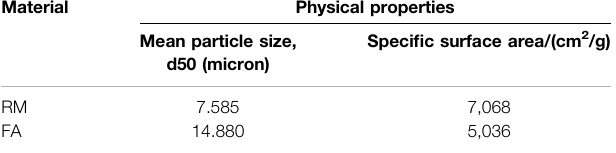
TABLE 2 | Physical properties of red mud and fl y ash.